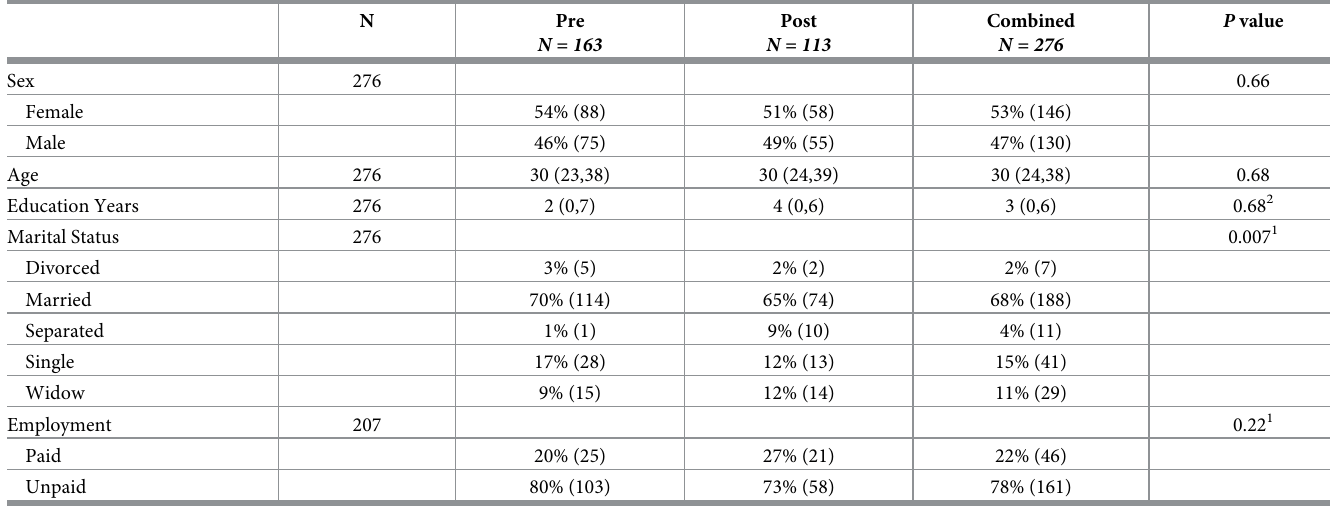
Table 1. Participant characteristics at baseline, by group and